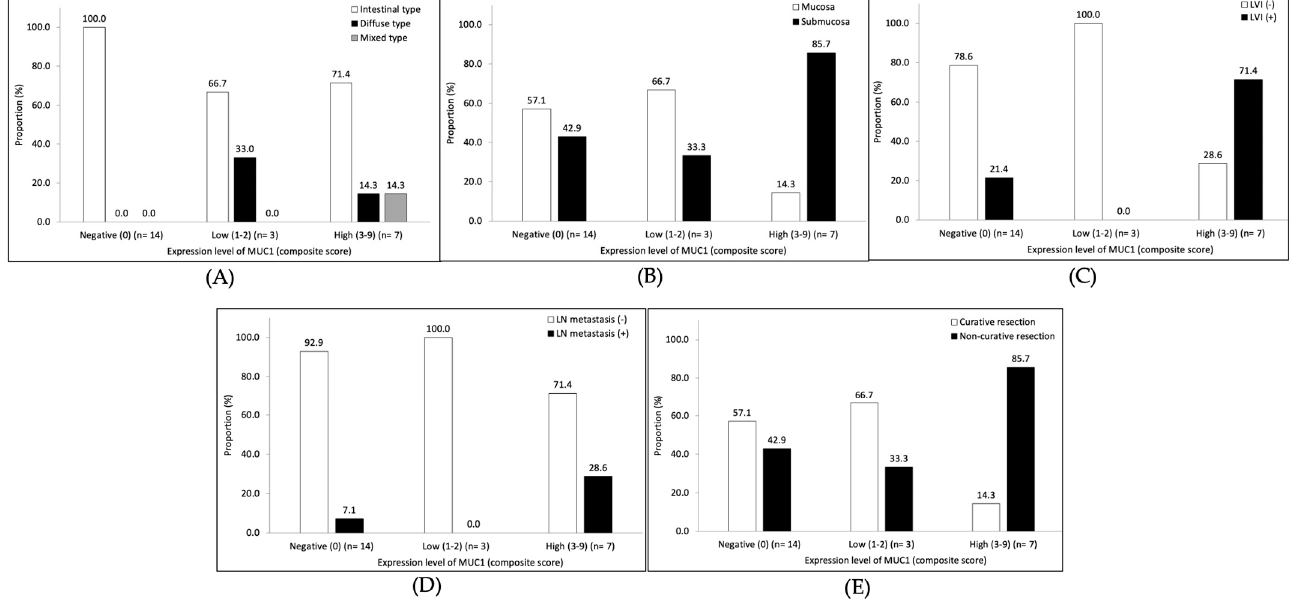
Figure 4. Subgroup analyses of the association between the level of MUC1 expression and pathological features in early gastric cancer patients. ( A ) Lauren classification, ( B ) tumor depth, ( C ) lymphovascular invasion (LVI), ( D ) lymph node (LN) metastasis, and ( E ) tumor category of curability according to endoscopic submucosal dissection criteria.